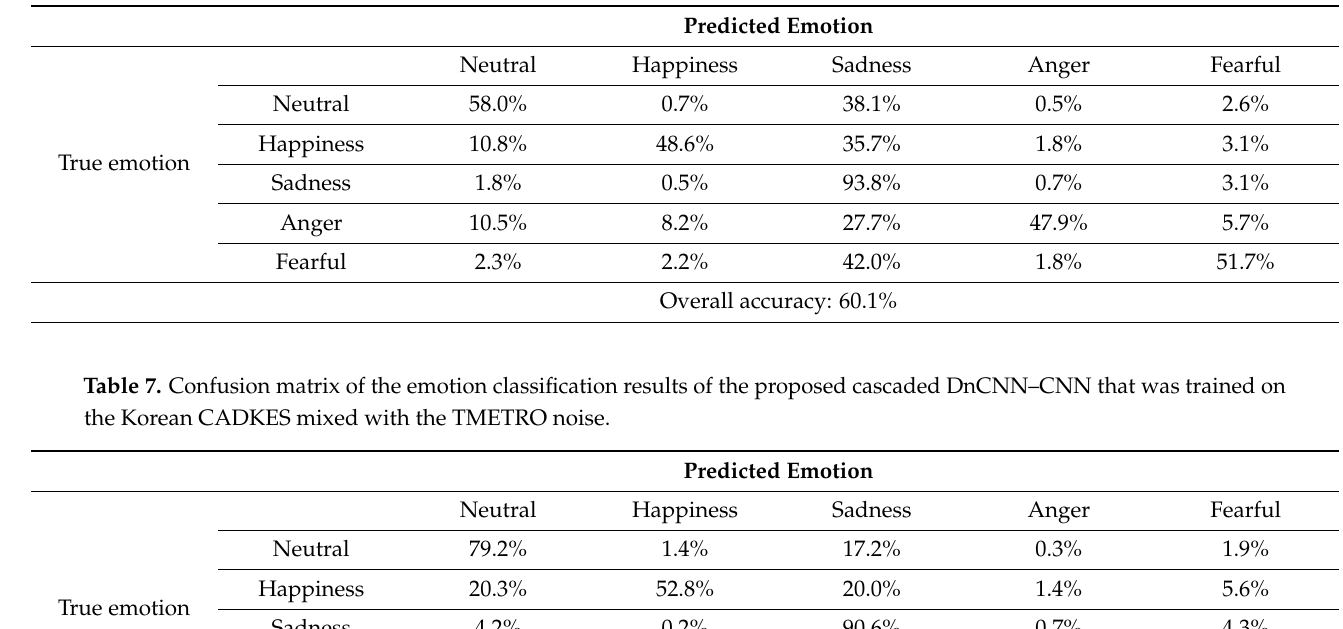
Table 6. Confusion matrix of the emotion classification results of the baseline CNN that was trained on the Korean CADKES mixed with the TMETRO noise.